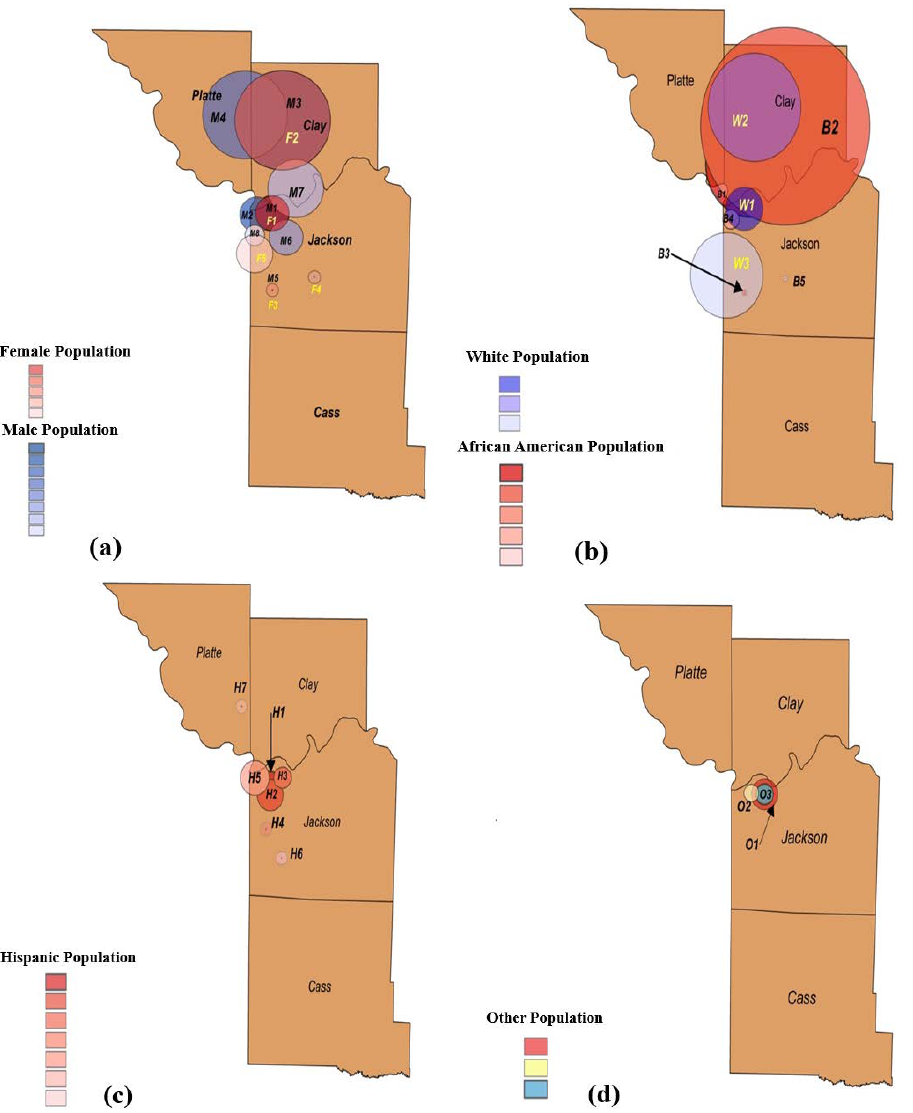
Figure 5. Emerging spatial clusters of COVID-19 with respect to demographic factors. Spatial clusters with respect to ( a ) gender, ( b ) White and African American populations, ( c ) Hispanic population, and ( d ) other races, i.e., Asian, American Indian, and Hawaiian and Pacific Islander .